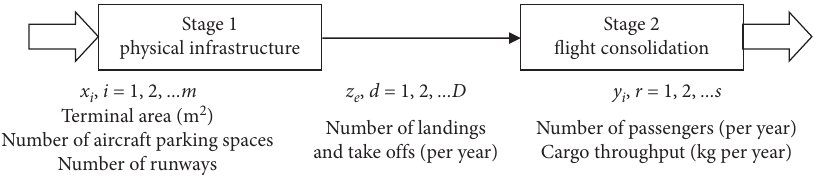
Figure 1: Stages of the estimation of efficiency in airports (source: adapted from Wanke